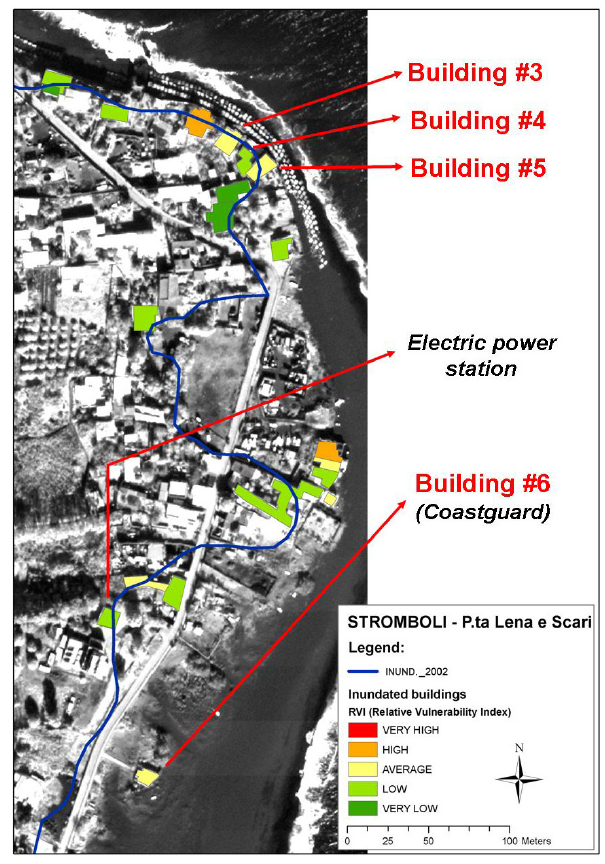
Fig. 6. Vulnerability map of Punta Lena (north) and Scari (south), Stromboli Island. The map layout corresponds to the red frame in Fig. 2. The blue line marks the limit of maximum inundation caused by the 2002 tsunami. Buildings from #3 to #6 have been used to validate the PTVA-3 Model results. Damage suffered by these buildings during the 2002 tsunami are shown in Figs. 10–13.